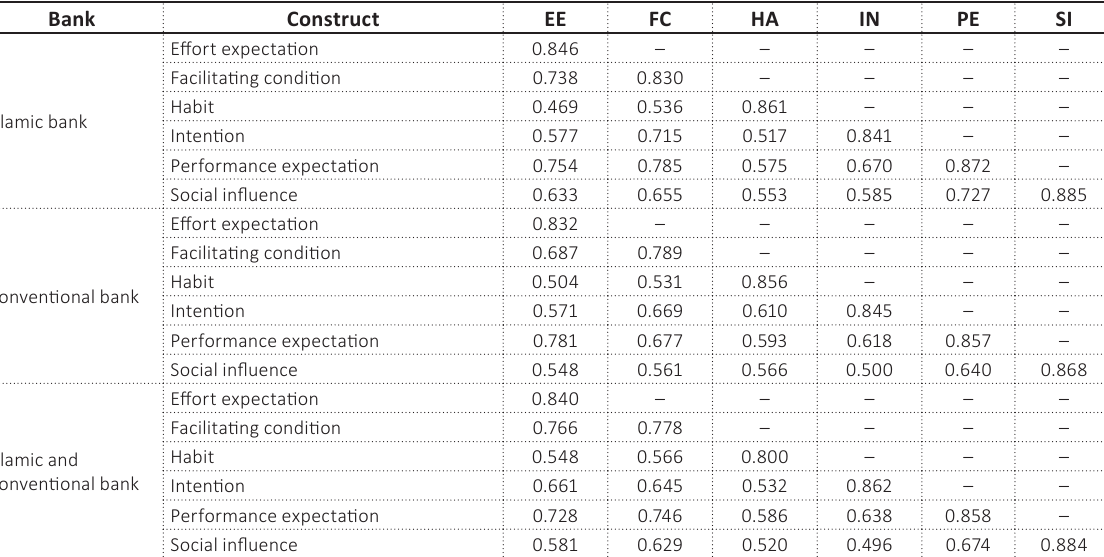
Table 4. Discriminant validity